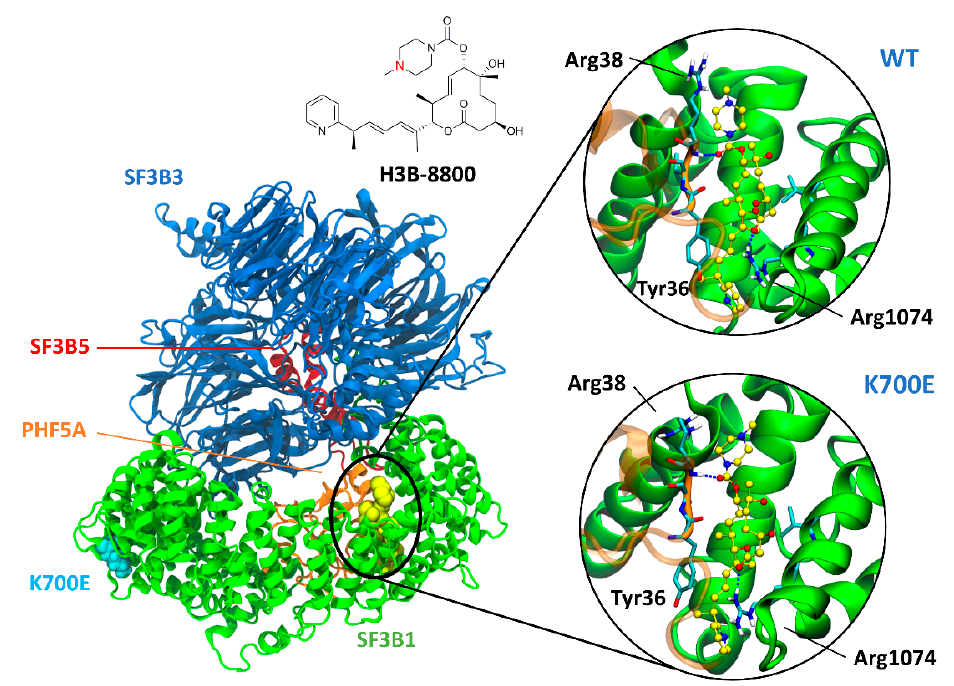
Figure 1. Representative structure of SF3b [25] in complex with the splicing modulator H3B-8800, as obtained from a cluster analysis of molecular dynamics (MD) simulations trajectories. SF3B1 (green), SF3B3 (blue), SF3B5 (red), and PHF5A (orange) are shown as cartoons, and the K700E and modulators sites in light blue and yellow van der Waals spheres. Insets show H3B-8800, highlighted in ball and sticks with carbon atoms depicted in yellow, in complex with wild type (WT) and K700E SF3B1. Sketch of H3B-8800 with the nitrogen atom subject to possible protonation marked in red (top).